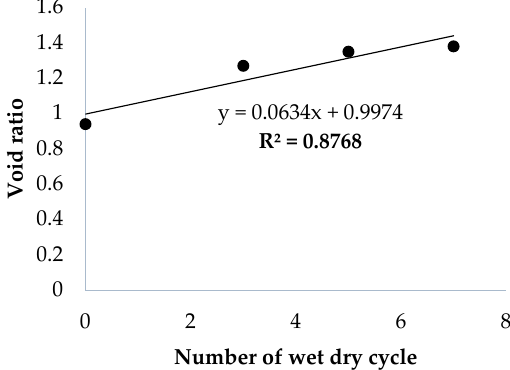
Figure 5. Change in void ratio with different wet-dry cycles.